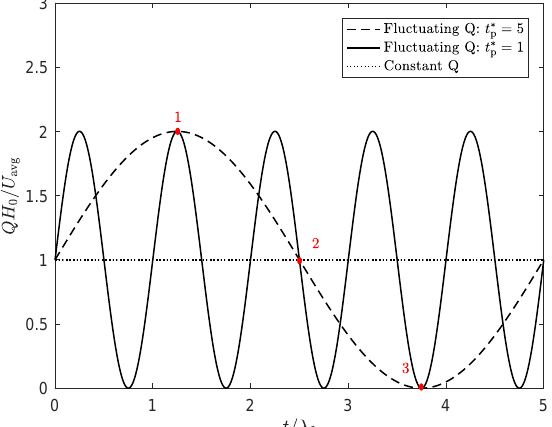
Figure 19. Sinusoidal flow rate with dimensionless period t ∗ p = t p / λ θ = 1 (solid line), and t ∗ p = t p / λ θ = 5 (dashed line) and the constant flow rate applied in previous results (dotted line). Figure 20 shows the swell ratio of the point of the free surface on Γ out as a function of dimensionless time for a fluctuating flow rate with both dimensionless periods t ∗ swell ratio is plotted for different values of γ ∗ .